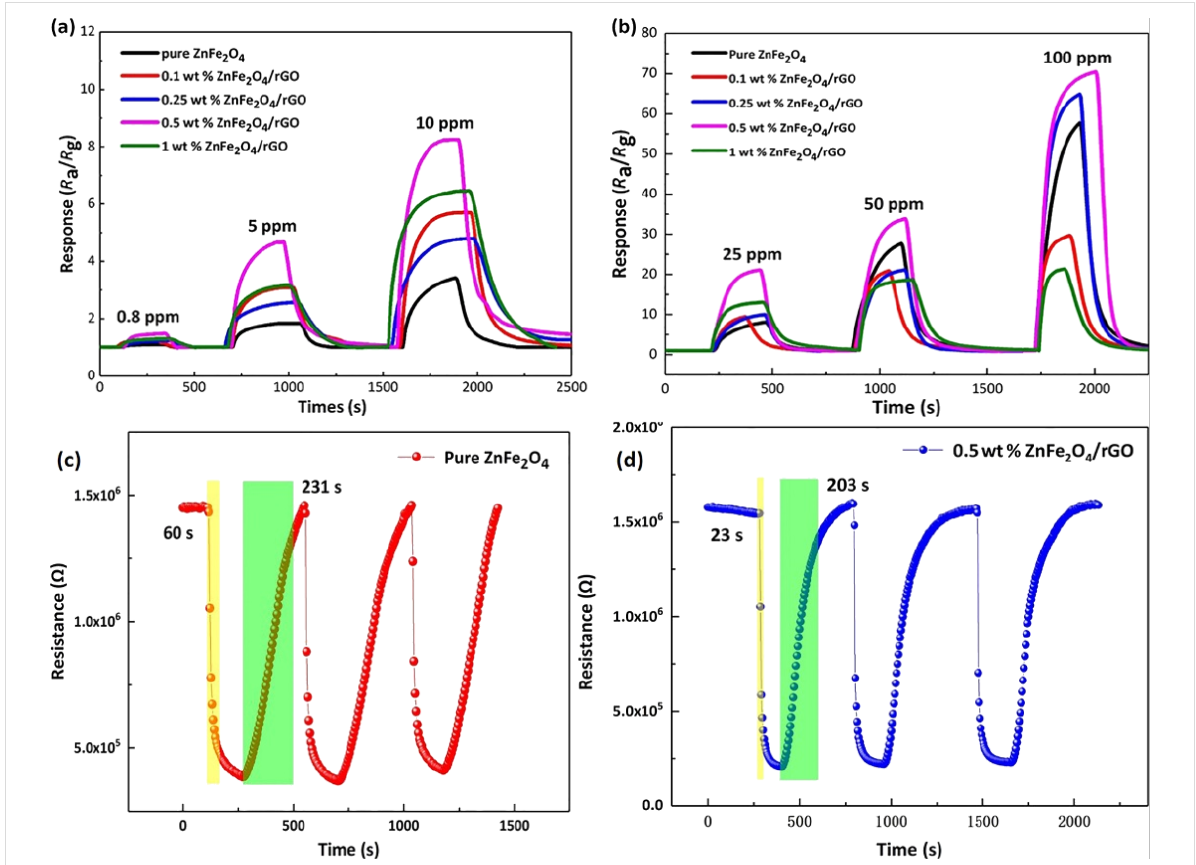
Figure 8: Dynamic response/recovery curves of the pure ZnFe 2 O 4 and the four ZnFe 2 O 4 /rGO gas sensors to (a) 0.8–10 ppm and (b) 25–100 ppm acetone at 200 °C. (c, d) The short term stability and the response/recovery time of the pure ZnFe 2 O 4 and the 0.5 wt % ZnFe 2 O 4 /rGO sensors to 10 ppm acetone measured in three cycles.